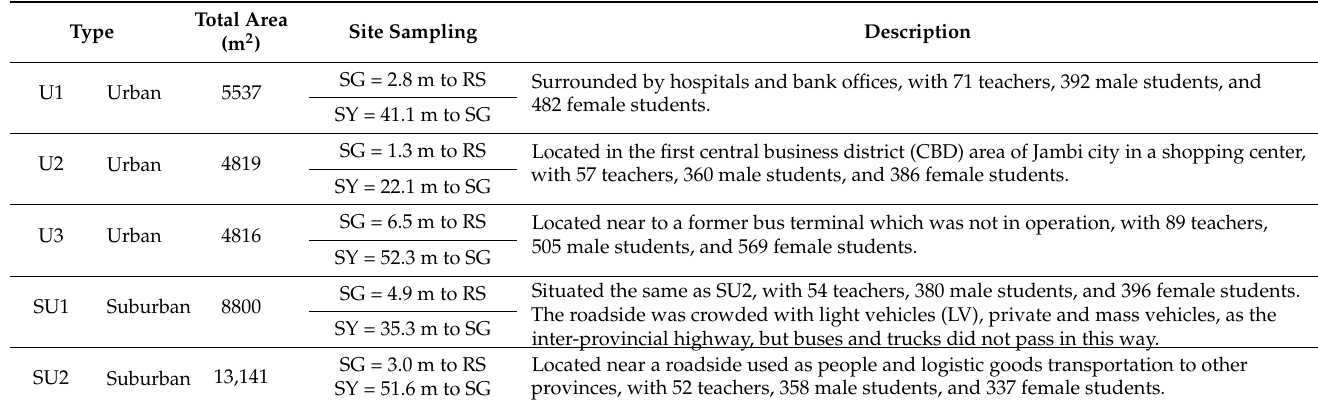
Table 1. Description of selected schools and ambient sampling sites in school environments.